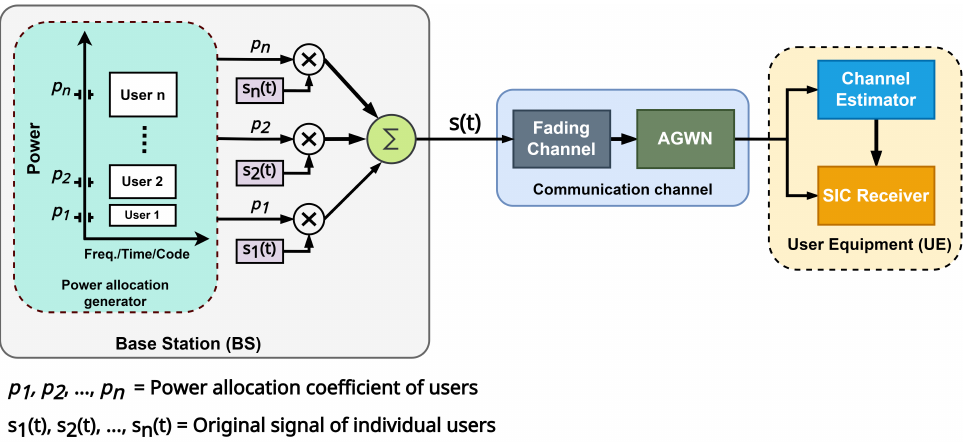
Figure 1. NOMA system architecture for downlink